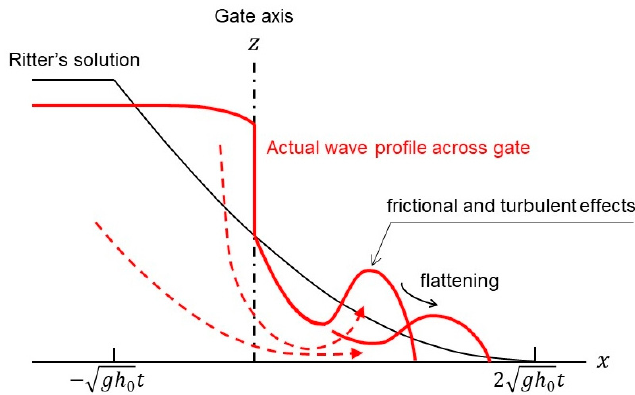
Figure 10. Initial stage of dam-break flow: Ideal vs. realistic profile.